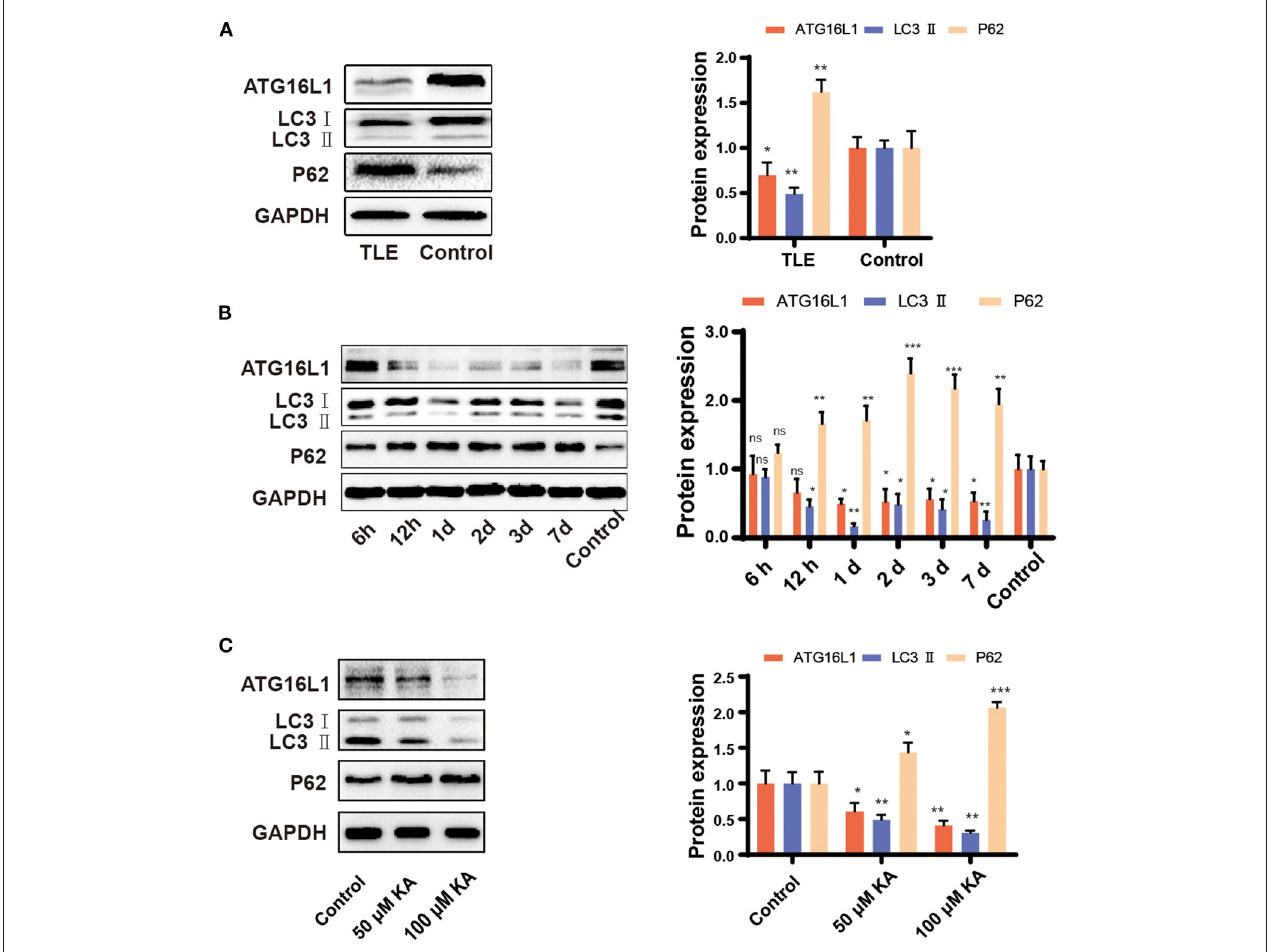
FIGURE 3 | Expression pattern of ATG16L1, LC3, and P62 in TLE patients, the mouse TLE model, and BV2 cells. (A) Temporal lobe tissues obtained from patients with TLE and controls, (B) mouse hippocampal tissues, and (C) BV2 cell lines were analyzed to assess the ATG16L1, LC3, and P62 protein expression levels through western blotting. Statistically significant differences were determined using the unpaired t -test. Data are presented as means ± SD . * p < 0.05; ** p < 0.01; *** p < 0.001; ns, not significant ( n = 3 per group). miR, microRNA; TLE, temporal lobe epilepsy; SD , standard deviation; KA, kainic acid; ns, not significant; LC3, light chain